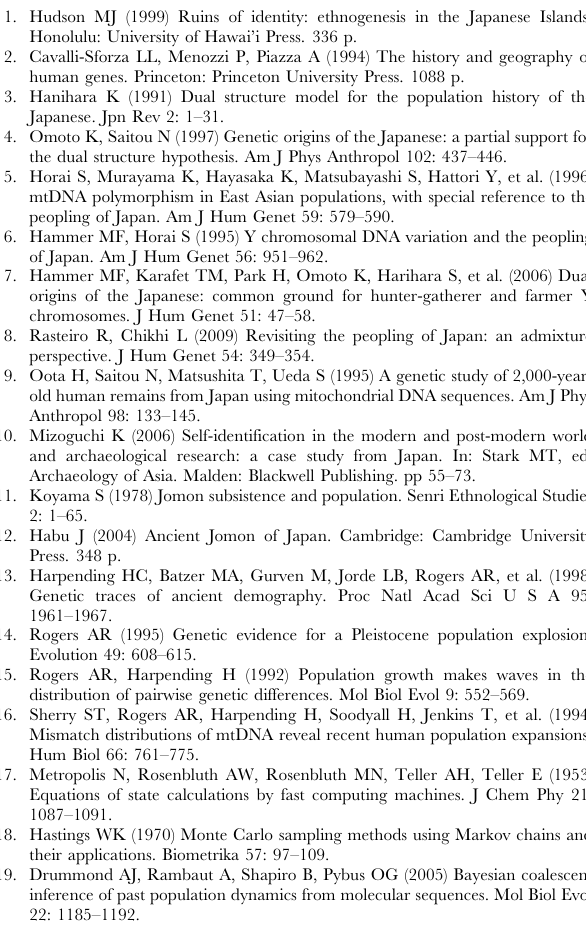
sequences. (TIF) Figure S2 BSP of female effective population size (N ef ) through time for Japanese mtDNA haplogroup D4 lineages. This result was generated by additional randomly sampling of 100 sequences. (TIF) Table S1 List of 952 mtDNA genomes identified in modern Japanese. This file described the haplogroup status and the reference information about 952 Japanese mtDNA